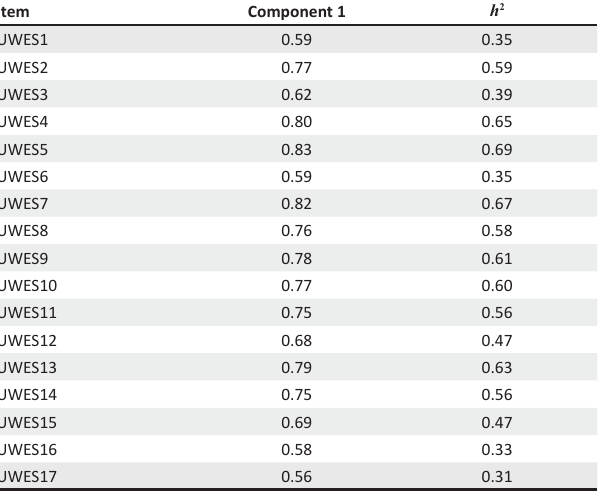
TABLE 3: Principal component analysis on the UWES.